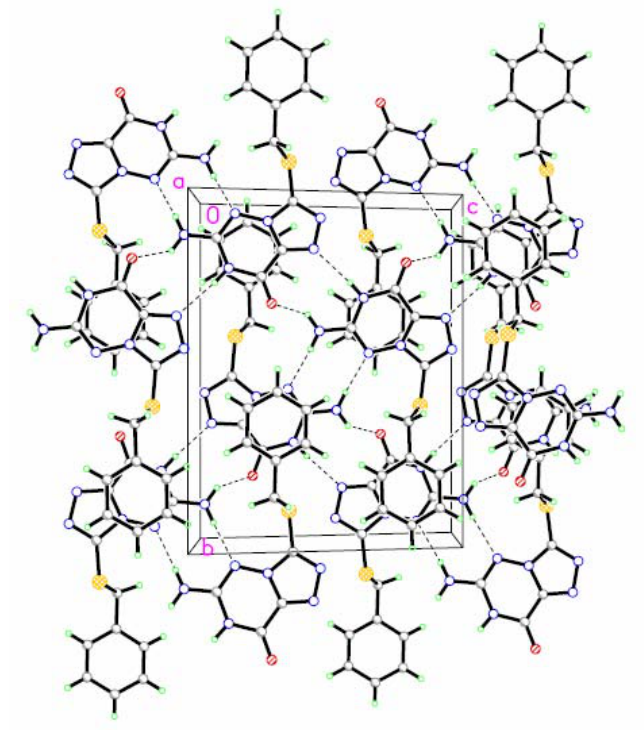
Figure 2. A perspective drawing of the packing arrangement of compound 4 .